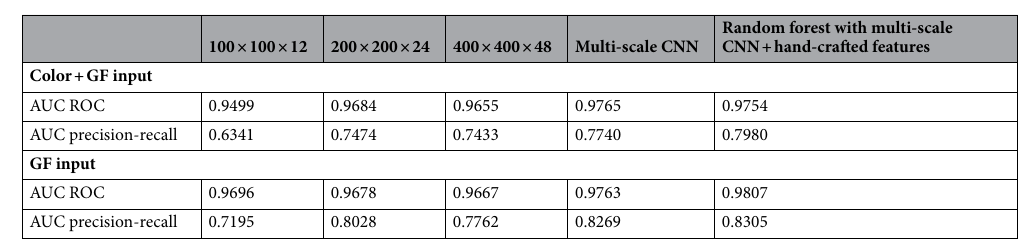
Table 2. Effect of CNN size, color image as input, and random forest with hand-crafted features on classification performance. Shown in the table are AUC of ROC and precision-recall curves from CNNs